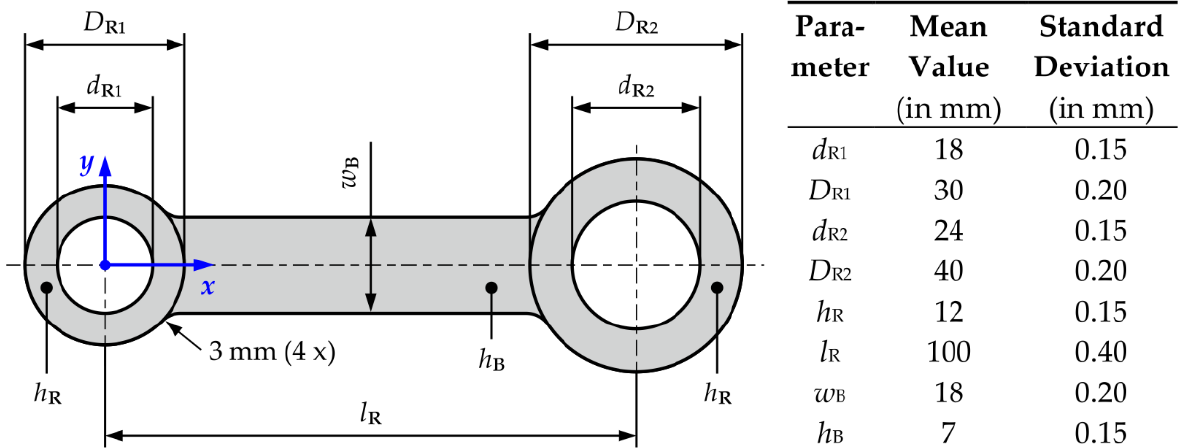
Figure 2. General geometry of a connecting rod with eight independent geometric parameters, in- cluding mean values and standard deviations of the normally distributed basic population depending on the geometric parameter; compare the previous publication [34].